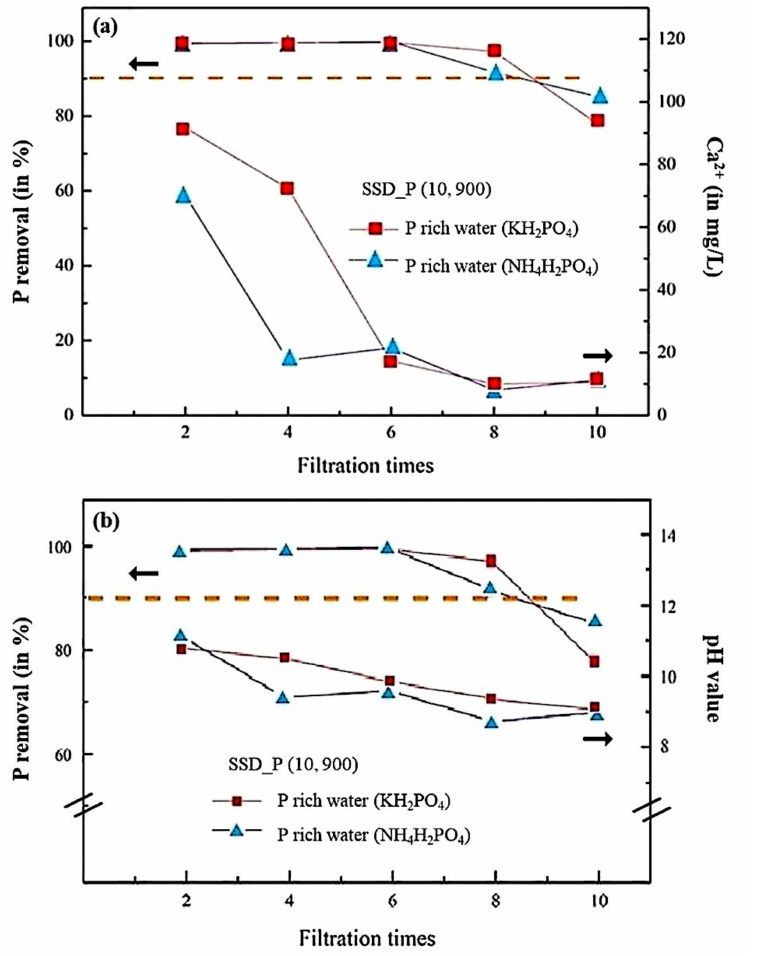
Figure 5. ( a ) The relations between filtering performances (P removal rates) and the released con- centrations of Ca 2+ as a function of filtering times are demonstrated for SSD_P (10, 900) in different P-rich water, (KH 2 PO 4 or NH 4 H 2 PO 4 ). ( b ) The relations between filtering performances (P removal rate) and pH values in the filtrated water as a function of filtering times are demonstrated for SSD_P (10, 900) in different P-rich water, (KH 2 PO 4 or NH 4 H 2 PO 4